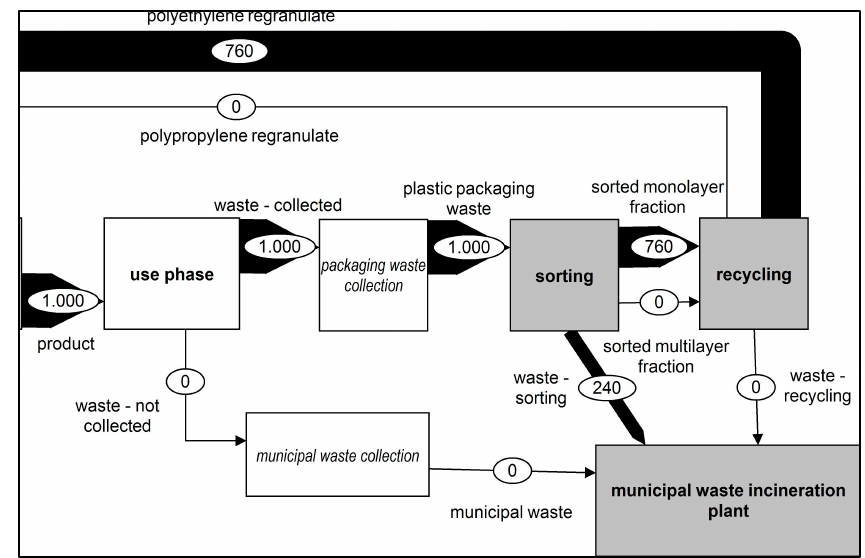
Figure 5. Representation of the changed material flows—Scenario 3.